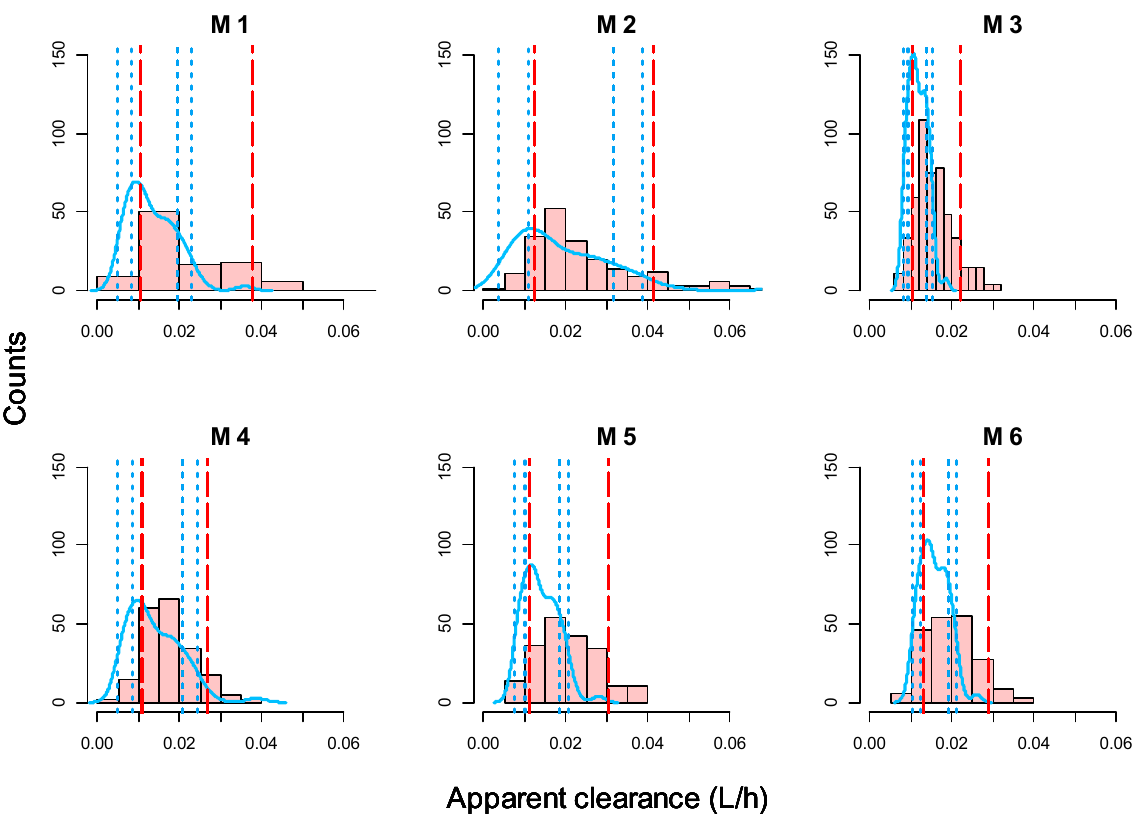
Figure 1. Histograms of EBEs for CL/F. Red dashed line; 20th and 80th percentile of EBEs CL/F; blue solid line represents the density of the simulated CL/F; blue dotted line, 95% confidence interval (CI) for the 20th and 80th percentiles of simulated CL/F. The M numbers represent the models described in Table 1.